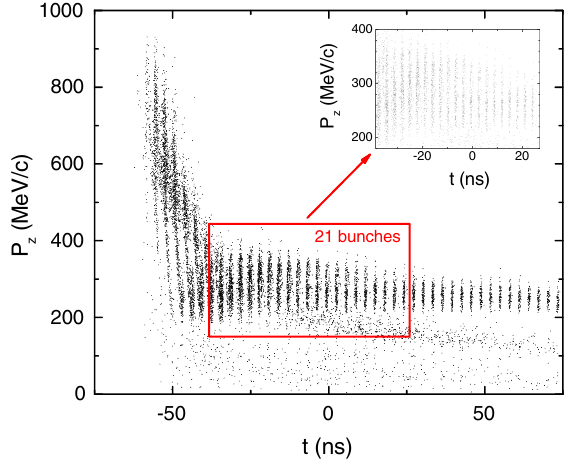
FIG. 3. Longitudinal phase space of a muon beam after phase rotation and just before entering the cooling channel. The phase rotation converts the initial single muon bunch with large energy spread into a train of bunches with much reduced energy spread of which we use only 21. The muons enclosed within the red box are also shown in Fig.